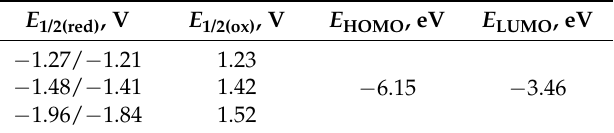
area; d obtained by EDX on thick films: M = Sn for the SnO 2 Ru-TT sample; M = In for the In 2 O 3 Ru-TT sample; e Effective photoresponse. The range of thermal stability of semiconductor oxides sensitized with the Ru-TT complex was determined by thermogravimetric analysis combined with mass spectral analysis of gaseous products (TG-MS). Figure 5 shows the MS signals of CO 2 (m/z = 12, m/z = 44), NO (m/z = 30), and